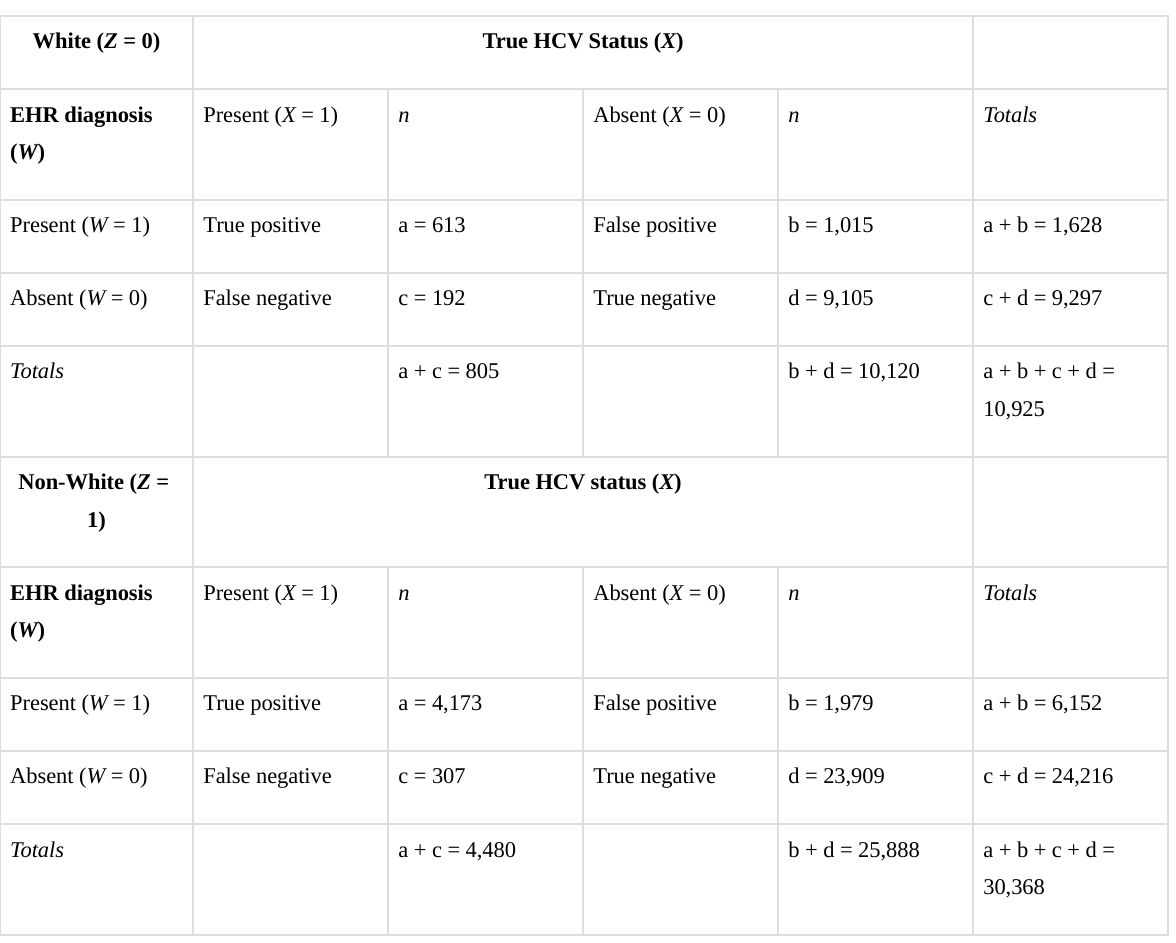
Table 3. Contingency table of an EHR indicator of HCV by true HCV status, stratified by race, in the validation subcohort.